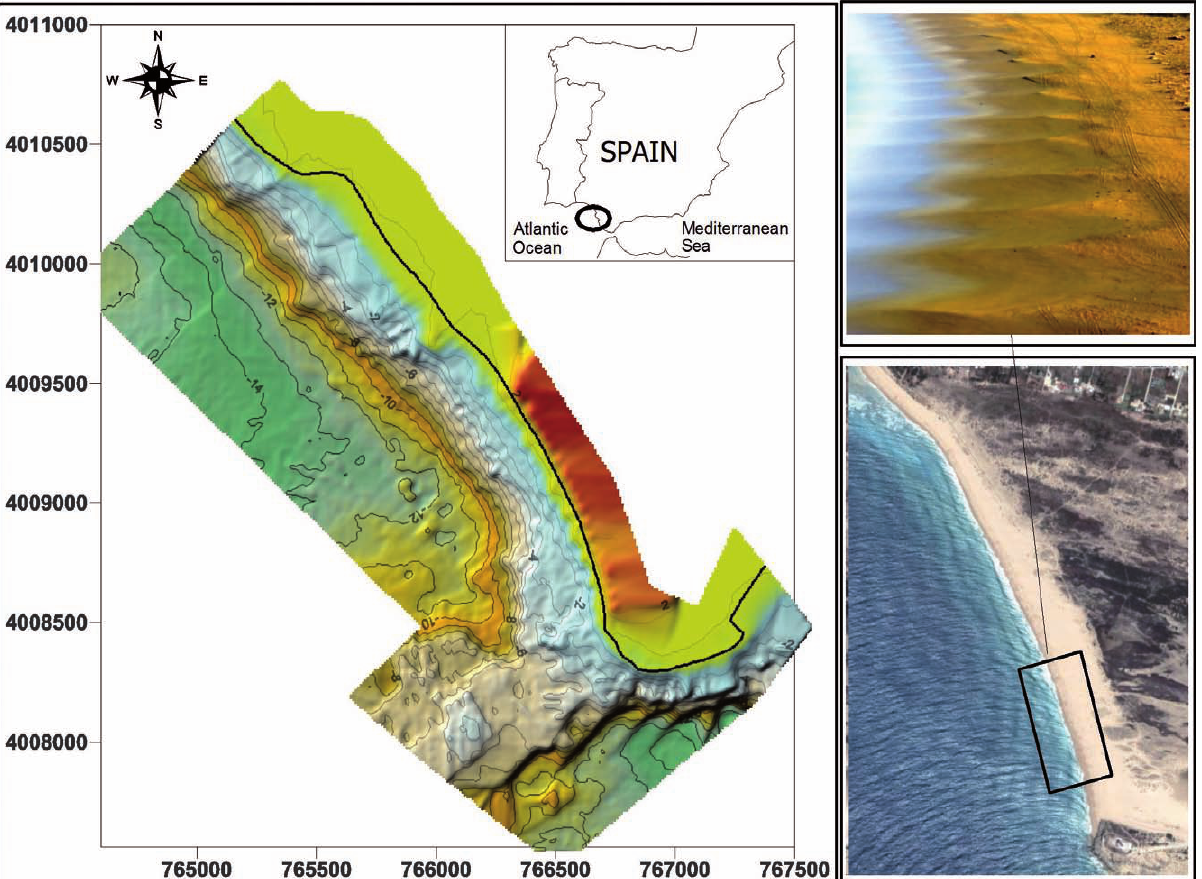
Fig . 1. – Location of the study site and detailed nearshore bathymetry of Trafalgar Beach surveyed in June 2006, with zoom on beach